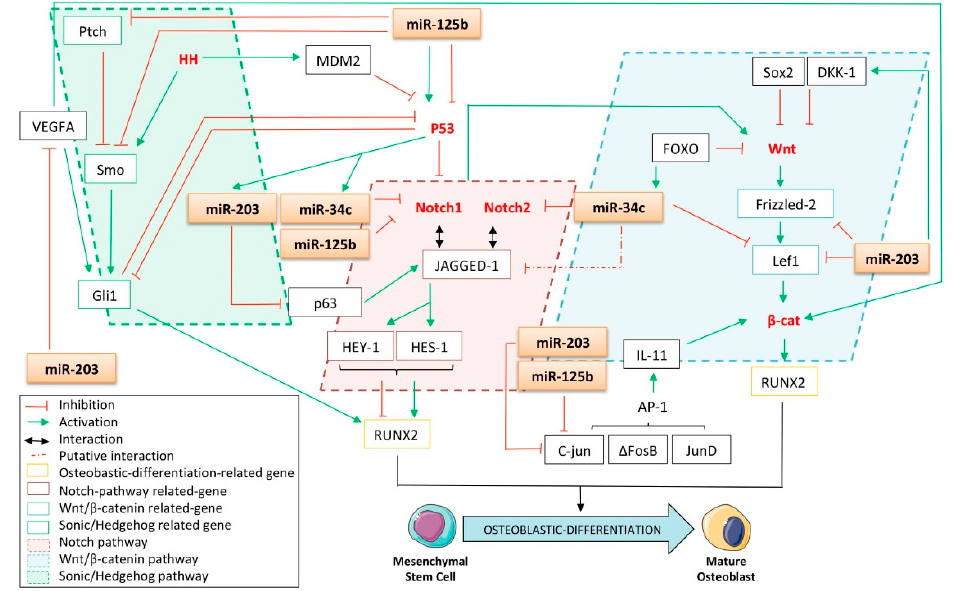
Figure 4. The p53-related miRNAs controls the osteoblastic differentiation through interplay with Notch, Wnt/ β -catenin, and Sonic/Hedgehog (HH) pathways. AP-1: Activator protein-1; β -cat: β -catenin; DKK-1: Dickkopf Wnt signaling pathway inhibitor 1; FOXO: Forkhead transcription factor; HES-1: Hairy/enhancer f split; HEY-1: Hes-related protein; HH: Sonic/Hedgehog; IL: interleukin; Lef1: lymphoid enhancer-binding factor 1; MDM2: mouse double minute 2 homologue; RUNX2: runt-related transcription factor 2; Ptch: Patched receptor; Smo: Smoothened; VEGFA: Vascular endothelial growth factor A.